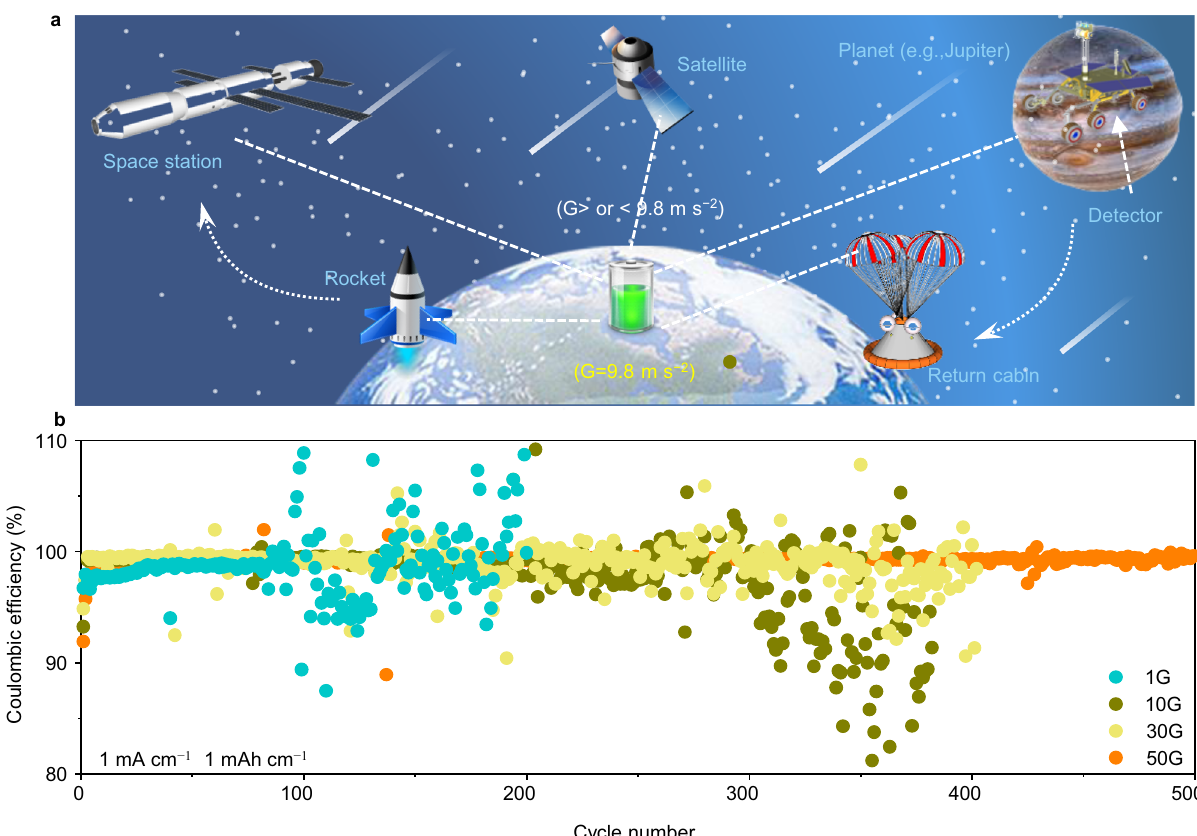
Fig. 1 The application background of Li metal batteries and its electrochemical performance under supergravity. a Potential applications of Li metal batteries in space exploration. b Long-term cycling of Li | |Cu cells with a fi xed capacity of 1 mA h cm − 2 at a current density of 1 mA cm − 2 under different gravity